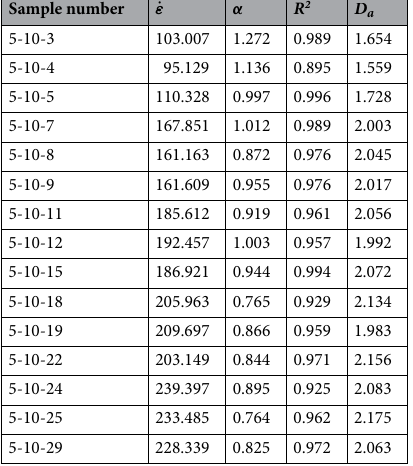
Table 5. Calculation results of fractal dimension.